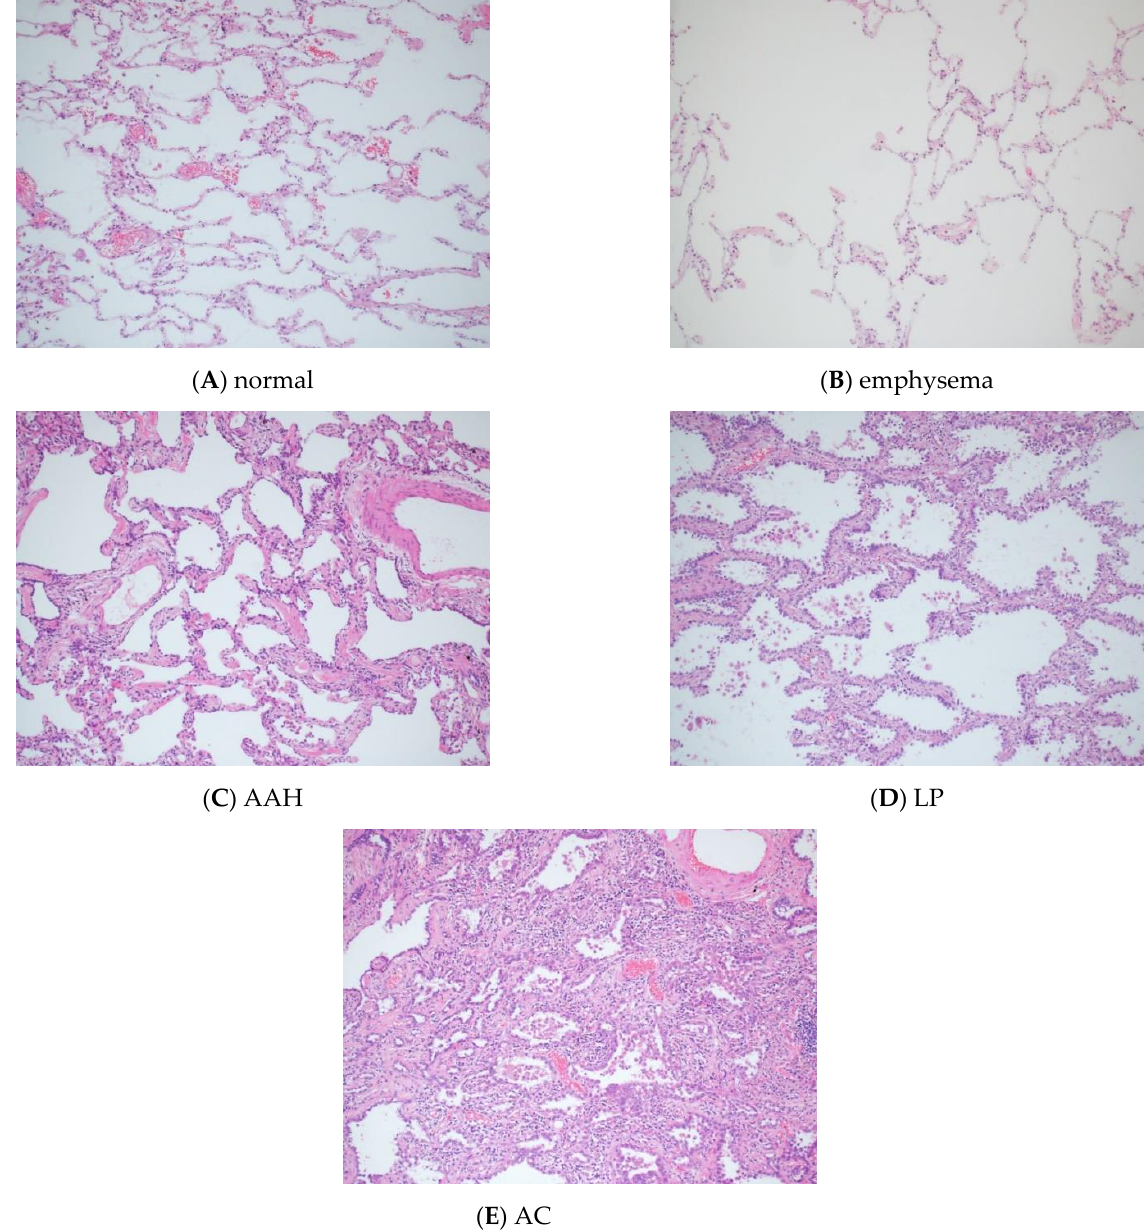
Figure 1. Representative histopathological images of ( A ) normal, ( B ) emphysema, ( C ) AAH, ( D ) LP and ( E ) AC. The magnification is 100× (the magnification of the objective lens being 10×). AAH, atypical adenomatous hyperplasia; LP, lepidic pattern of adenocarcinoma; AC, invasive adenocarcinoma.